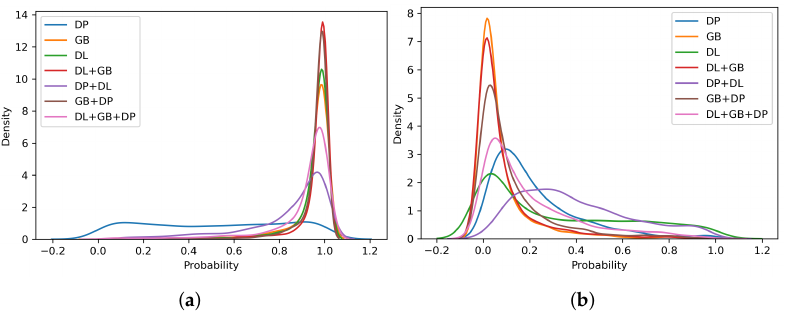
Figure 9. Comparison between ROCs of our self-trained PAD systems in an intra- (dashed) and cross- (solid) sensor scenario on the GreenBit ScreenSpoof dataset from LivDet 2021.